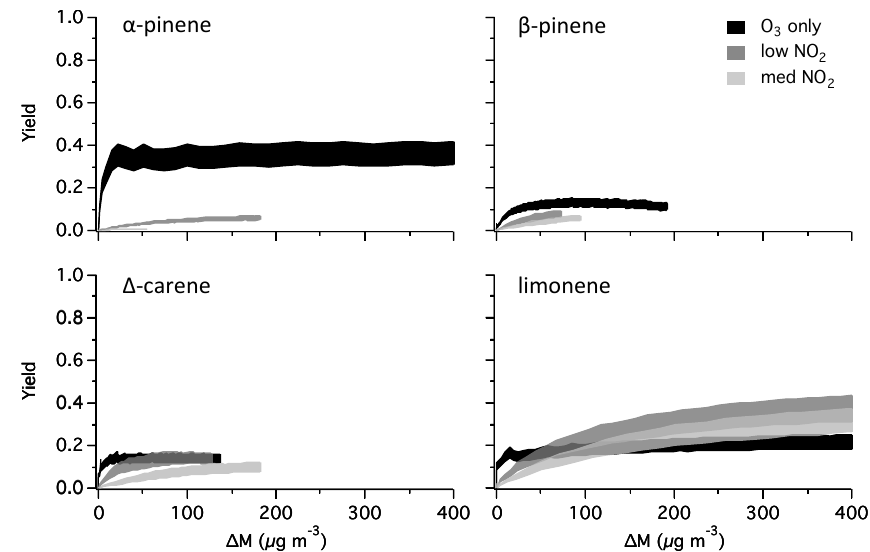
Figure 4. Yield vs. (cid:49)M for each experiment. (cid:49)M is corrected for wall losses (described in Supplement). Uncertainty ranges on yields arise from a constant 15% relative error on (cid:49)M calculated based on two replicate experiments, propagated with modeled (cid:49) HC values using the range of 10 − 15 to 10 − 12 cm 3 molec − 1 s − 1 for k RO for the low and medium NO 2 experiments for each monoterpene. O 3 - 2 + RO 2 only experiments do not have an analogous (cid:49) HC uncertainty range since all O 3 was assumed to react with the monoterpene directly, so uncertainty range on these traces is based exclusively on (cid:49)M